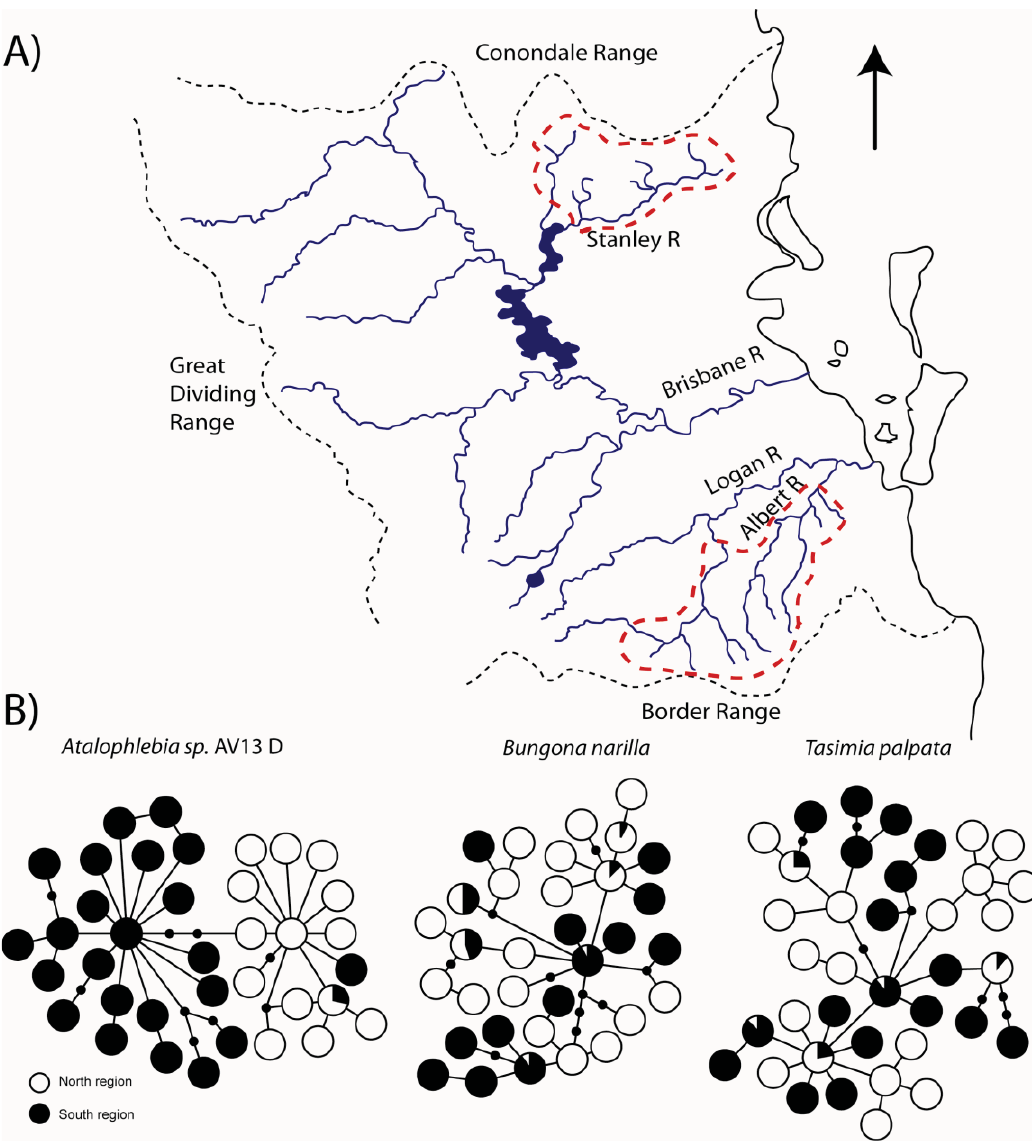
Figure 3. ( A ) Map of Conondale (north) and Lamington (south) regions; ( B ) Cytochrome Oxidase 1 haplotype networks for three species sampled in both north and south regions [29-31]; ( C ) We used a hierarchical Approximate Bayesian Computation method, analyzed with MTML-msbayes [38], to estimate the number of divergence events ( (cid:5) ) that can explain the shared pylogeographic break in these three co-distributed taxa. Within the msbayes pipeline, we simulated 1,000,000 datasets (parameterized by random draws from predefined ranges) and calculated 23 different summary statistics from each dataset to create a prior distribution. The same summary statistics were calculated for our observed datasets (based on the CO1 region of the mtDNA molecule) and compared to the simulated summary statistics to generate posterior distributions for the variance of (cid:4) (time since divergence), average (cid:4) and (cid:5) . The posterior distributions shown here for E( (cid:4) ) and (cid:5) were estimated using the local regression method. For the histogram describing (cid:5) , the red bars show the posterior distribution while the black bars show the prior distribution. For a more detailed explanation of msbayes see